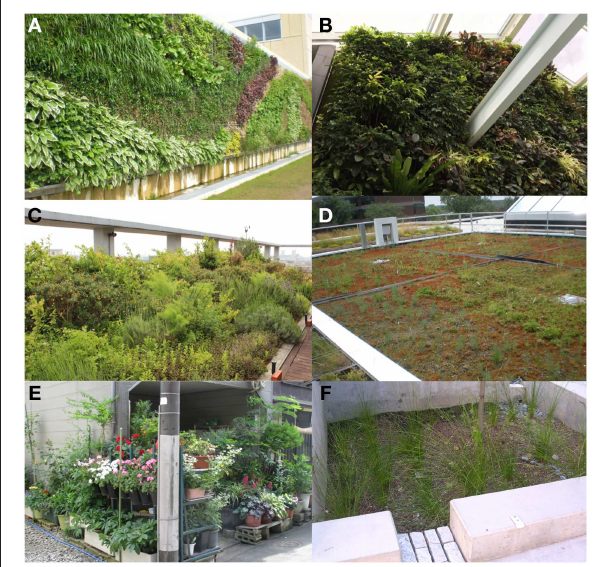
FIGURE 2 | Examples of constructed ecosystems. (A) outdoor living wall; (B) indoor living wall; (C) intensive (deep growing medium) green roof; (D) extensive (shallow growing medium) green roof; (E) container gardens; (F)